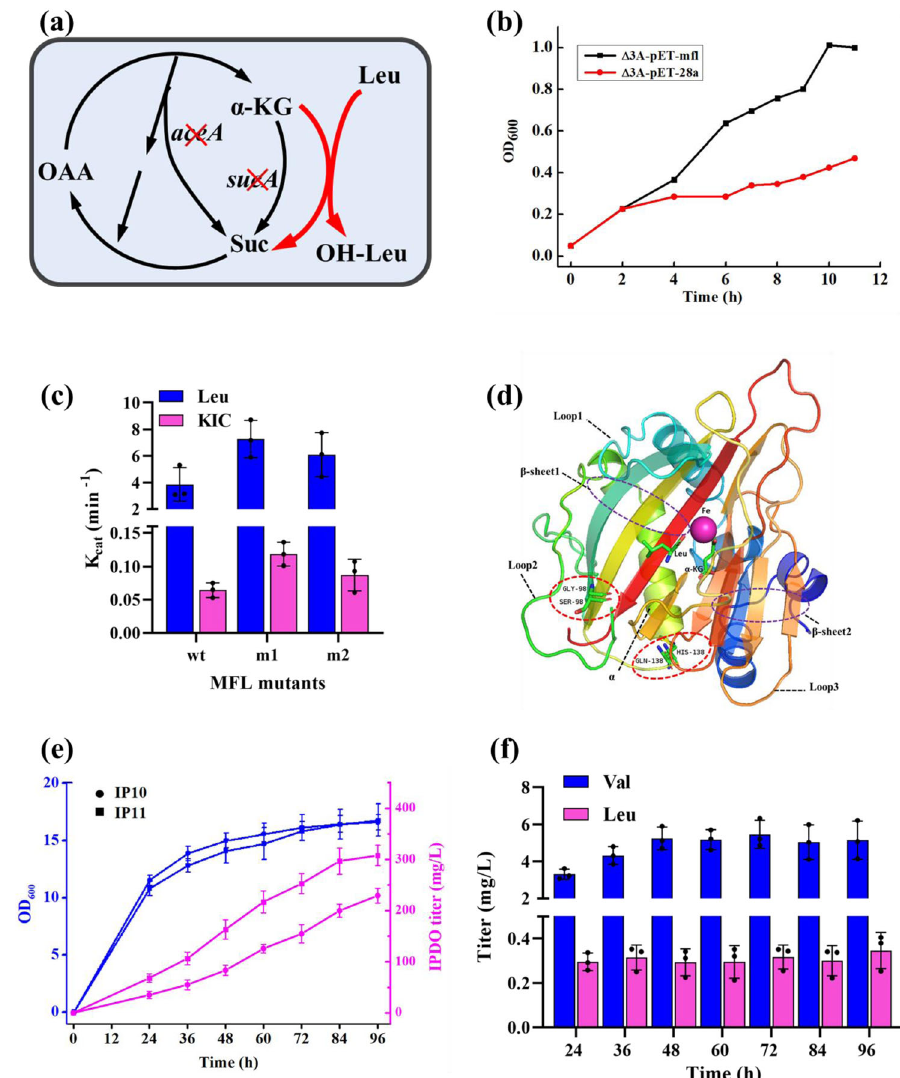
Fig. 6 Directed evolution of MFL for screening MFL random mutants generated by EP-PCR. a Schematic representation of the screening principle: hydroxylation of leucine by MFL is coupled with oxidation of α -KG to succinate (red arrows), and therefore the growth of a succinate-auxotrophic strain is strictly depended on leucine hydroxylation. b Growth curves of Δ 3A strain carrying pET28a or pET-m fl in the M9 medium added with 4 g/L yeast. The initial OD was set as 0.05. c Enzymatic activities of MFL and its two mutants MFL m1 and MFL m2 towards leucine and KIC. d Positions of mutation residues found in MFL m1 and MFL m2 . Fe 2 + is shown as a pink sphere. Leucine, α -KG, and two mutant residues are shown in sticks. L represents loop, α re presents alpha helix. e Growth curve (blue curves) and IPDO production (pink curves) in strain IP10 and IP11 cultivated in shake fl asks. f Determination of valine and leucine concentrations in the fermentation broth of strain IP11 cultivated in shake fl asks. Samples were taken every 12 h. For c , e , f the average, and s.d. of three biologically independent experiments are shown. Source data are provided as a Source Data fi